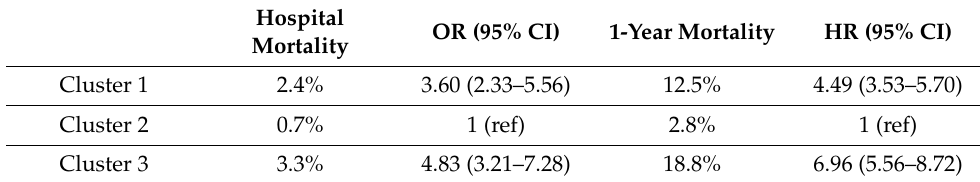
Figure 5. ( A ) Hospital mortality among different clusters of admission Hyperchloremia; ( B ) One-year mortality among different clusters of admission hyperchloremia. Table 2. Mortality outcomes according to the distinct clusters of hyperchloremia patients.